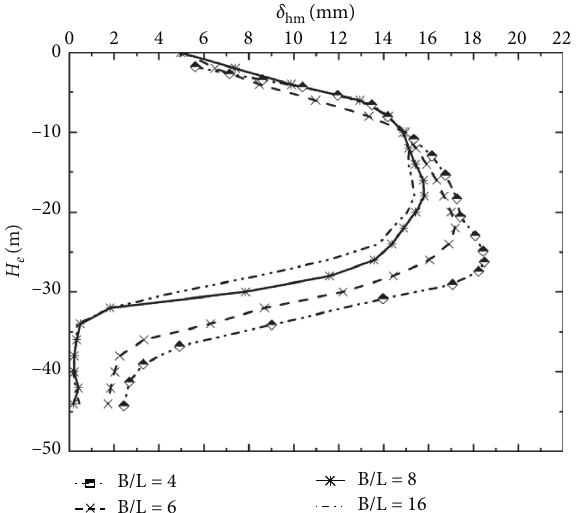
Figure 18: Deflection of diaphragm wall under the different value of ( B / L )